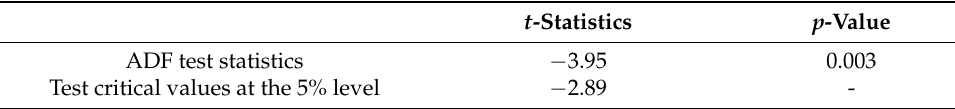
Table A2. The results of ADF test for lumber